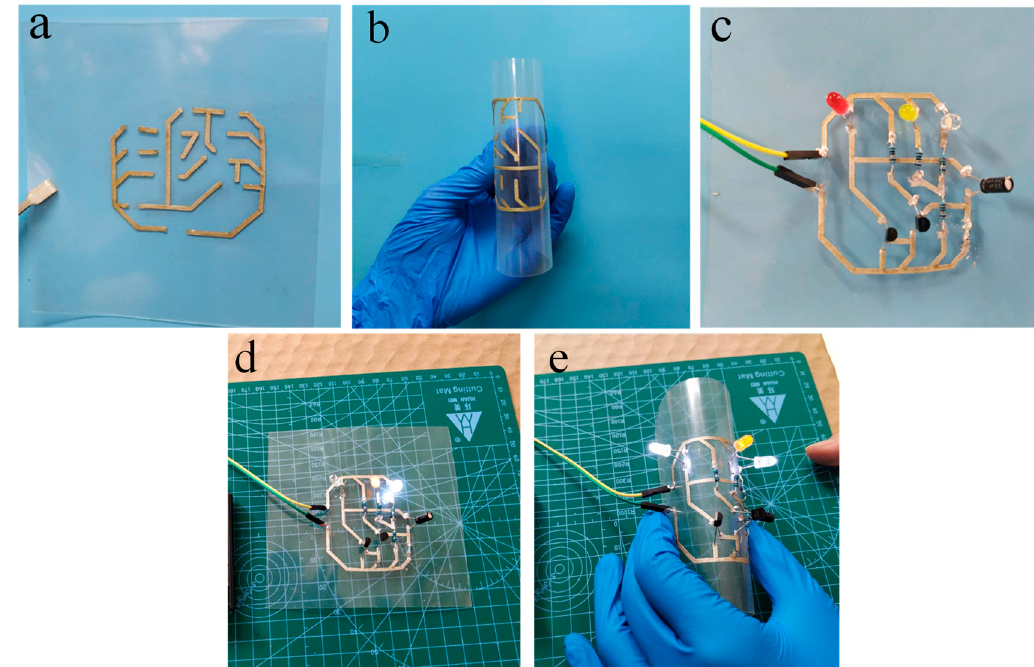
Figure 8. Application of PC-ECAs (PC-1) in printed circuits. ( a ) Printed circuits with line width of 1mm, ( b ) printed circuit at a flexural state, ( c ) a flashing LED device on the printed circuit, ( d ) a flashing LED device working under the flat state, and ( e ) the lightness does not change when the devices are close to ninety degrees bending.